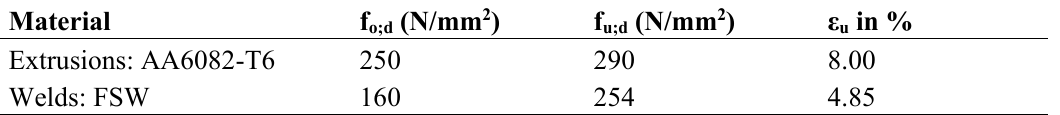
Table 1. Material properties of alloy AA6082-T6 and friction stir welded (FSW)